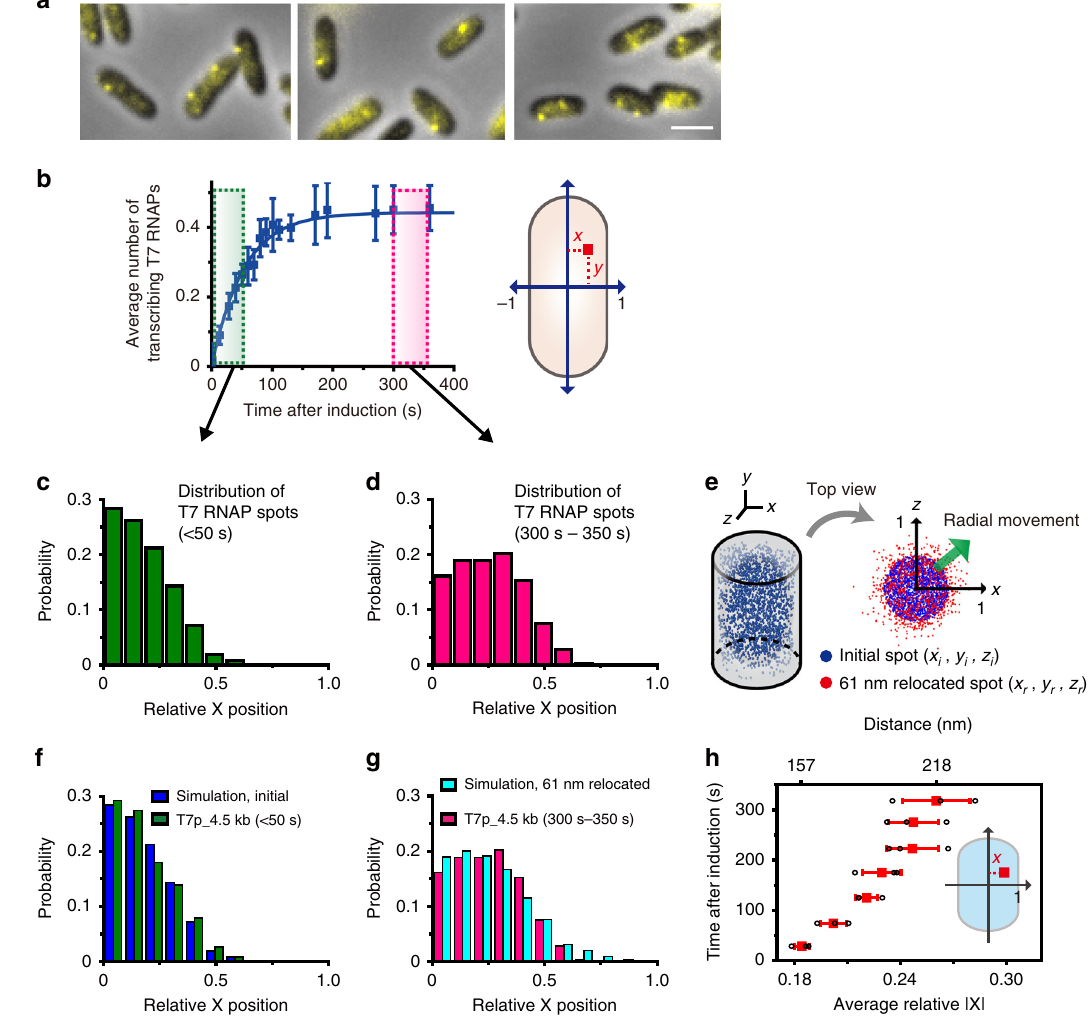
Fig. 2 Gene locus moves to the nucleoid periphery by T7 RNAP-driven transcription. a Representative images of T7p_4.5kb cells acquired late (>270 s) after adding IPTG. Fluorescent foci denote the locations of gene loci actively transcribed by T7 RNAP. Scale bar, 2 μ m. b Analysis of the subcellular localization of gene locus under transcription. Left panel of b is a reproduction of Fig. 1e, blue line, for convenience. The green box indicates the time window for the cells at the initial transcription stage, <50 s. The purple box indicates the time window for the cells between 300 and 350 s after IPTG induction. The right panel in b shows normalization of the cell size. The location of each fl uorescent spot was determined as relative coordinates ( x , y ) to take into account differences in cell size. The x-axis corresponds to the short axis of the cell. c , d Distributions of the subcellular localization of transcribing eYFP-T7 RNAP foci along the short axis. c The distribution of the locations of transcribing RNAP spots within 50 s after induction (total of 363 fl uorescent foci). d The distribution of the locations of transcribing RNAP spots between 300 and 350 s after induction (total of 360 fl uorescent foci). e Simulation of gene loci movements. A total of 100,000 random spots with a 70-nm localization error were generated in the cylindrical coordinates (blue spots). Red spots indicate the fi nal locations of each spot randomly moved in the radial direction by 61 nm on average. f , g Comparison of the simulated and experimental results. f The distribution obtained by the simulation (blue bar) was similar to the distribution of the initial transcription stage (green bar, same as Fig. 2c). g The spots obtained by the simulation in Fig. 2e were randomly moved in the radial direction by 61 nm on average (cyan bar). The distribution following these movements is comparable with the distribution in Fig. 2d (purple bar). h The average relative position of the transcribing gene loci after induction. The distance in 3D geometry is presented. Data represent mean ± s.d. obtained from three independent experiments (red). Each point represents independent measurement